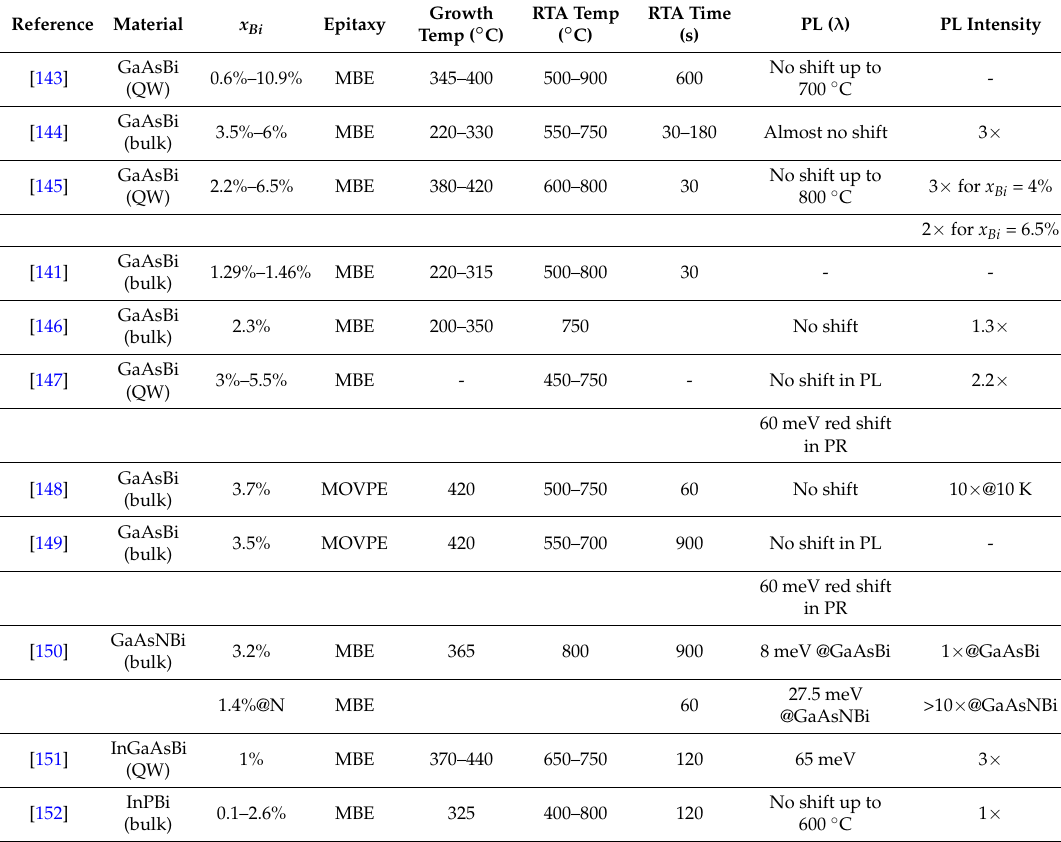
Table 5. Summary of rapid thermal annealing (RTA) on various dilute